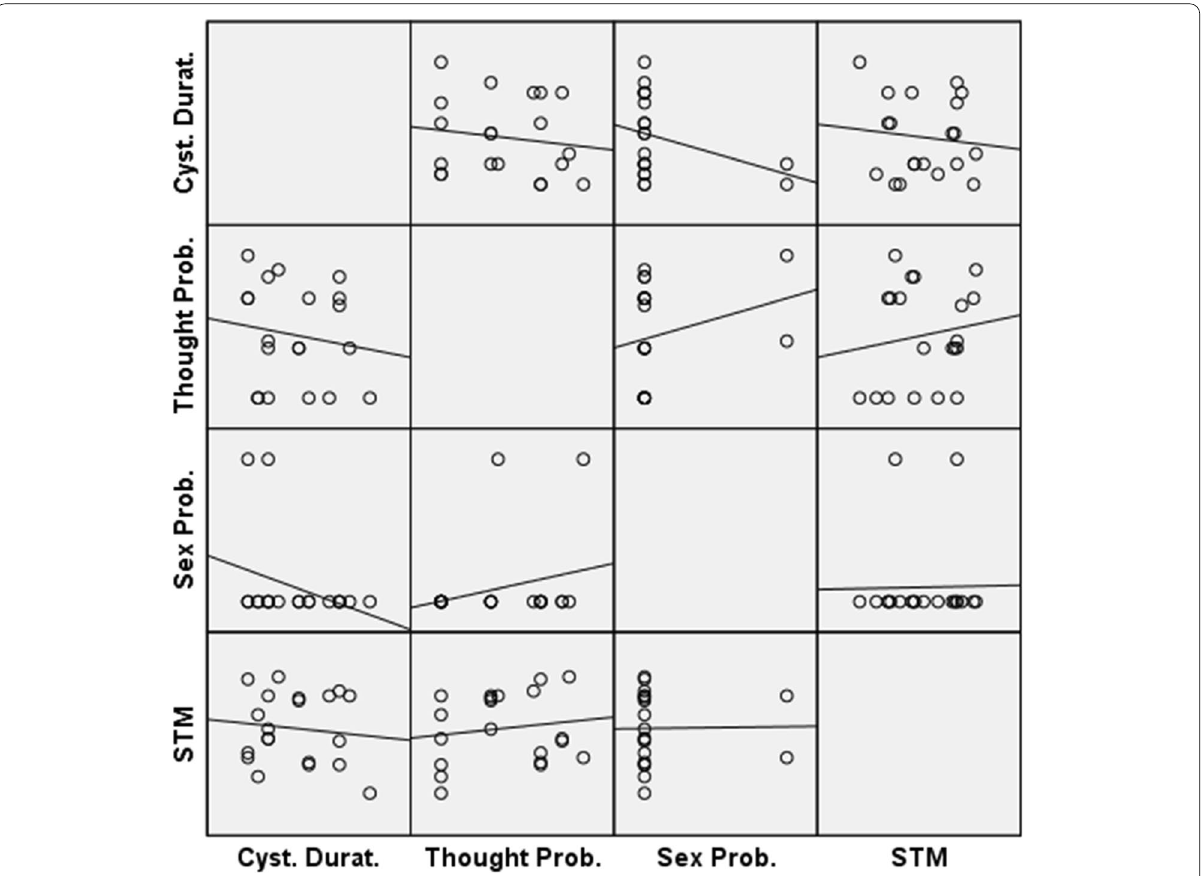
Fig. 1 Correlation between cysteamine therapy duration and short-term memory, sex problems, and thought problems. STM, short-term memory; cyst, cysteamine; sex prob, sex problems; thought prob, thought